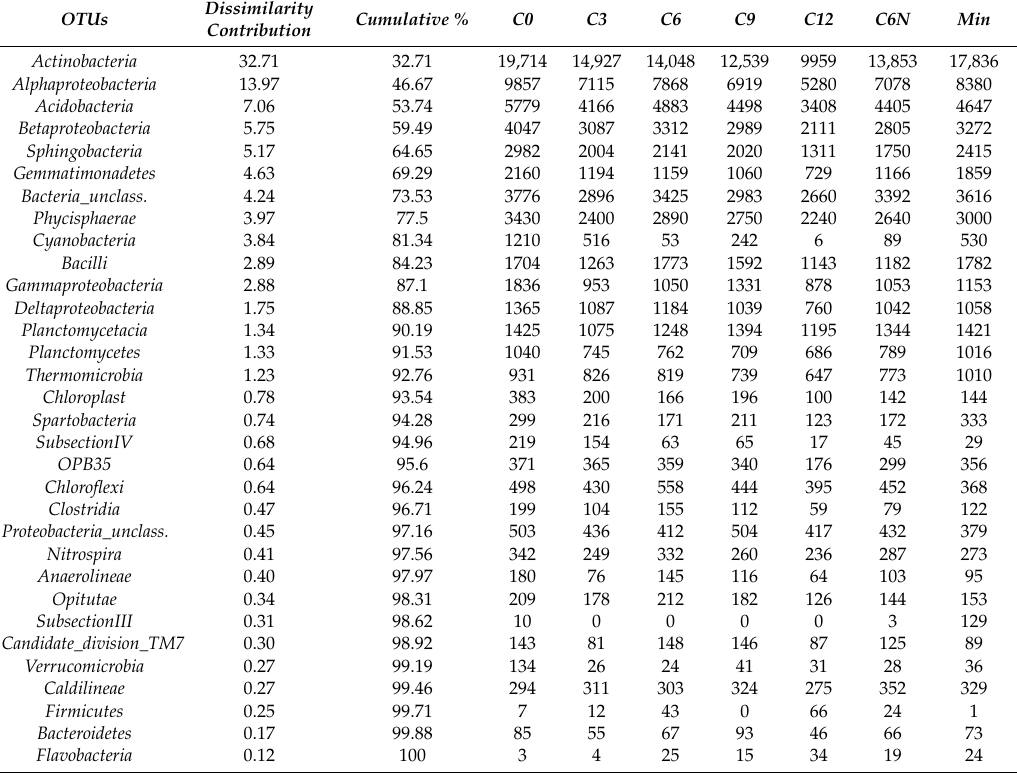
Table 3. Similarity percentage (SIMPER) analysis showing the principal operational taxonomic units (OTUs) responsible for the di ff erences between treatments *.